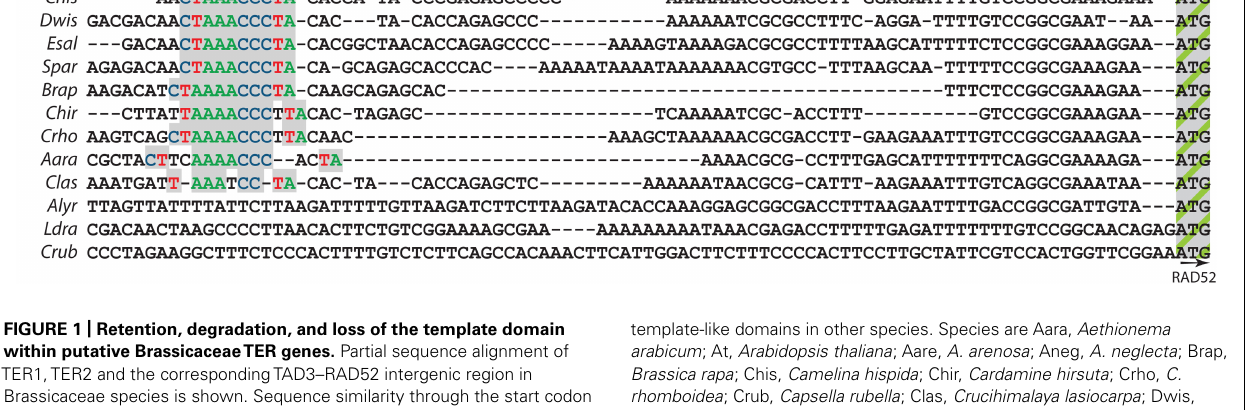
template-like domains in other species. Species are Aara, Aethionema arabicum ; At, Arabidopsis thaliana ; Aare, A. arenosa ; Aneg, A. neglecta ; Brap, Brassica rapa ; Chis, Camelina hispida ; Chir, Cardamine hirsuta ; Crho, C. rhomboidea ; Crub, Capsella rubella ; Clas, Crucihimalaya lasiocarpa ; Dwis, Dimorphocarpa wislizenii ; Esal, Eutrema salsugineum ; Ldra, Lepidium draba ; Spar, Schrenkiella parvula